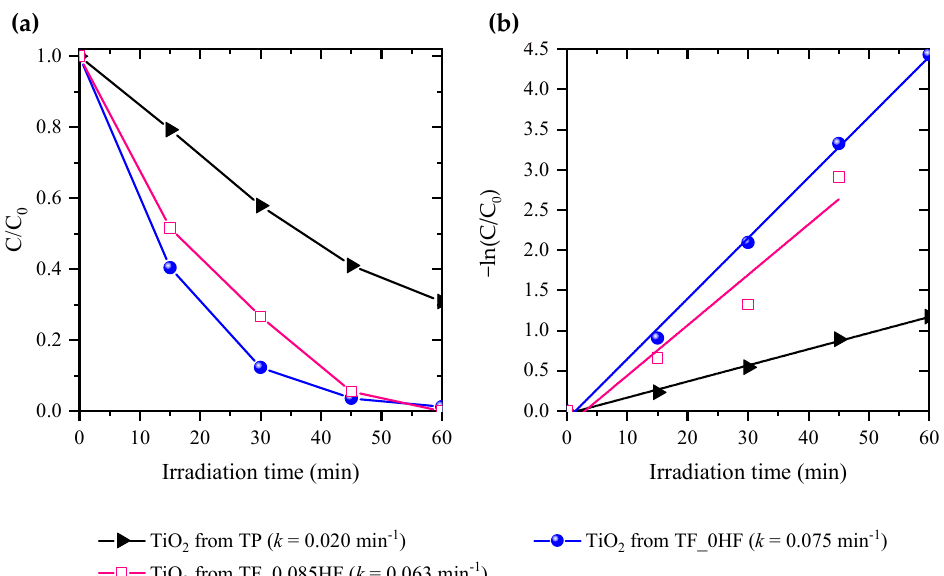
Figure 6. Photocatalytic degradation of phenol as a function of concentration to initial concentration ( a ) and ln(C/C 0 ) ( b ).